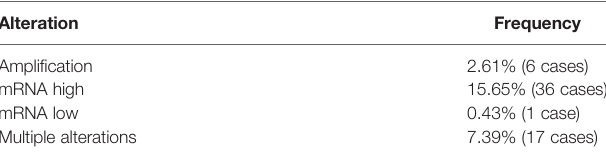
TABLE 1 | Summary for lung adenocarcinoma gene altered in 26.09% of 230 cases.